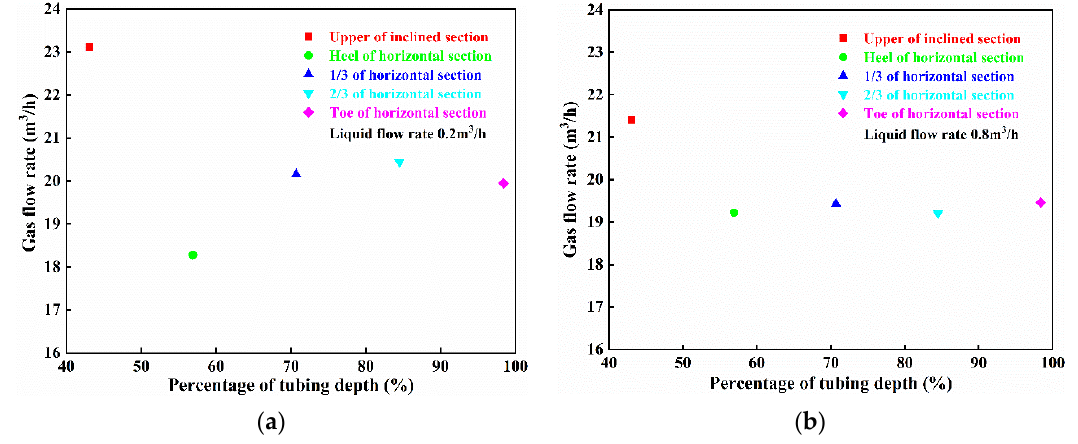
Figure 6. Gas flow rate of liquid ‐ carrying in different tubing depths: ( a ) liquid flow rate 0.2 m 3 /h; ( b ) liquid flow rate 0.8 m 3 /h.